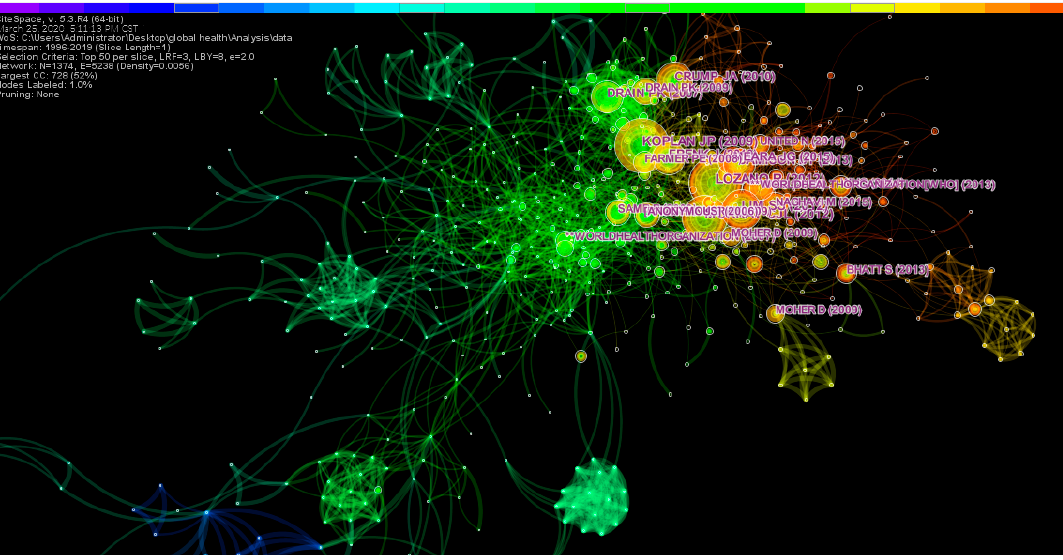
Figure 7. Knowledge map of co-citation literature. The selection criteria for the study of literature co-citation networks is top 50 per slice, and the largest citation sub-network is displayed.